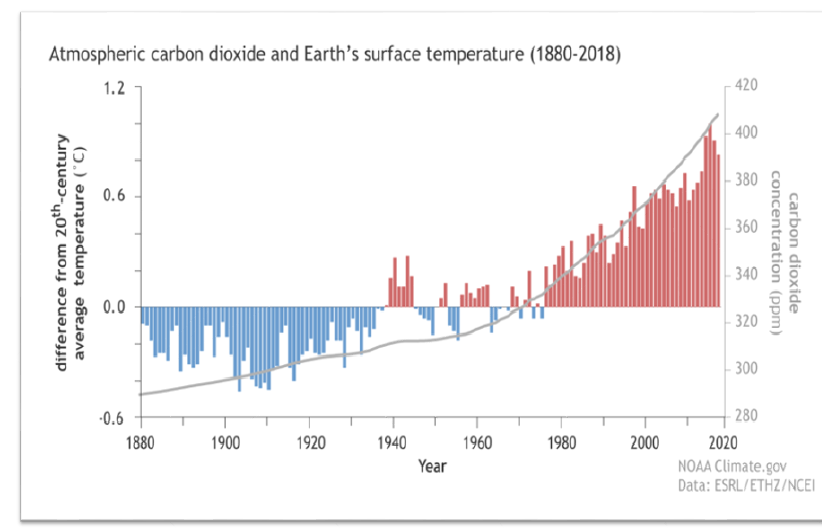
Figure 1. Evolution of Earth’s average temperature in comparison with the atmospheric carbon dioxide over the last decades. Reproduced with permission from [4], copyright 2020, NOAA Climate.gov.